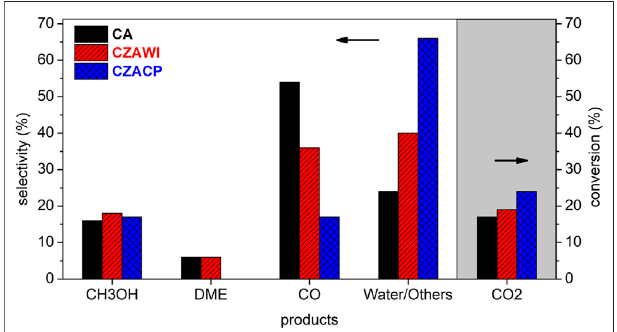
FIGURE 12| Productselectivity and CO 2 conversion (hatched area) at a steady state.